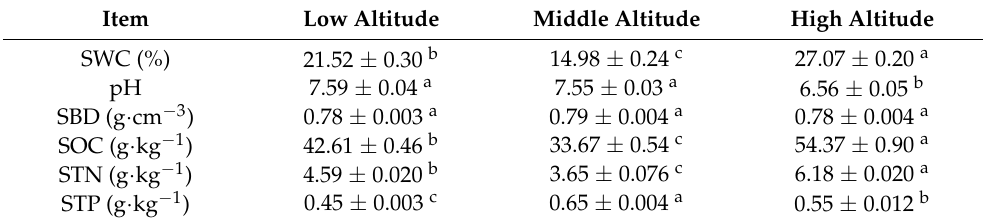
Table 1. Characteristic values of soil environmental factors at different